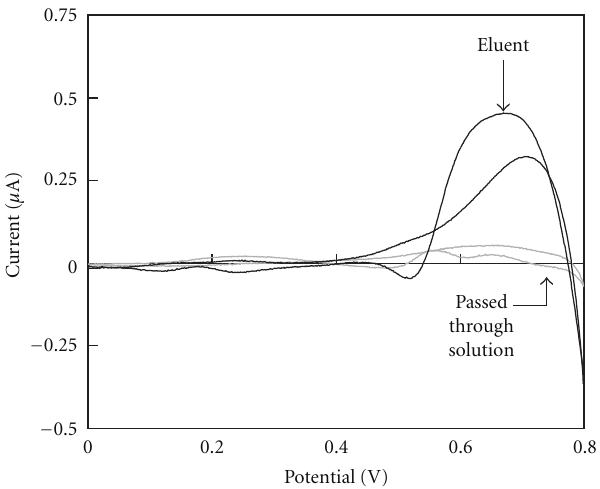
Figure 6: Response of bisphenol A with this sensing